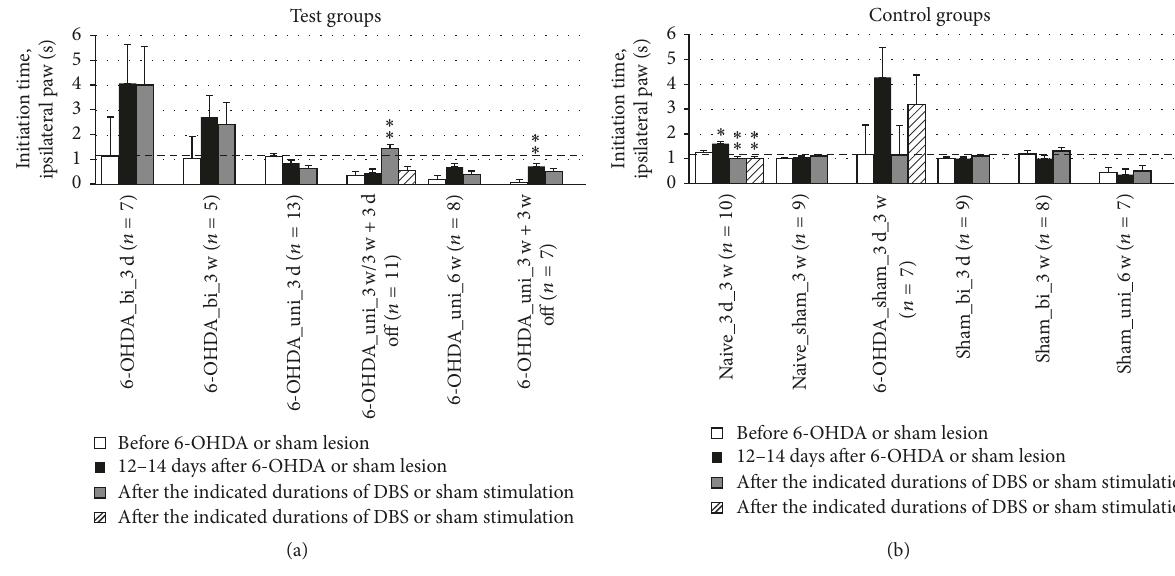
Figure 7: Short-term and long-term effects of DBS with uni- and bipolar electrodes on the akinesia of hemiparkinsonian rats as measured by the initiation time of the first adjusting step of the ipsilateral forepaw in the stepping test. (a) and (b) refer to test groups and controls, respectively. The dashed line at 1s allows for an easier comparison with Figure 6 and between (a) and (b). Different column patterns indicate different times of behavioral testing; white: before 6-OHDA or sham lesion; black: 12–14 days after 6-OHDA or sham lesion; gray and hatched: after the durations of DBS or sham stimulation indicated in the group labels. For experimental details see Table 1. Significance levels are indicated with asterisks as follows: ∗∗ 𝑝 ≤ 0.01 , ∗ 𝑝 ≤ 0.05 , b (borderline): 0.05 < 𝑝 ≤ 0.08 according to one-way ANOVA. Asterisks above black columns refer to white columns; all others refer to black